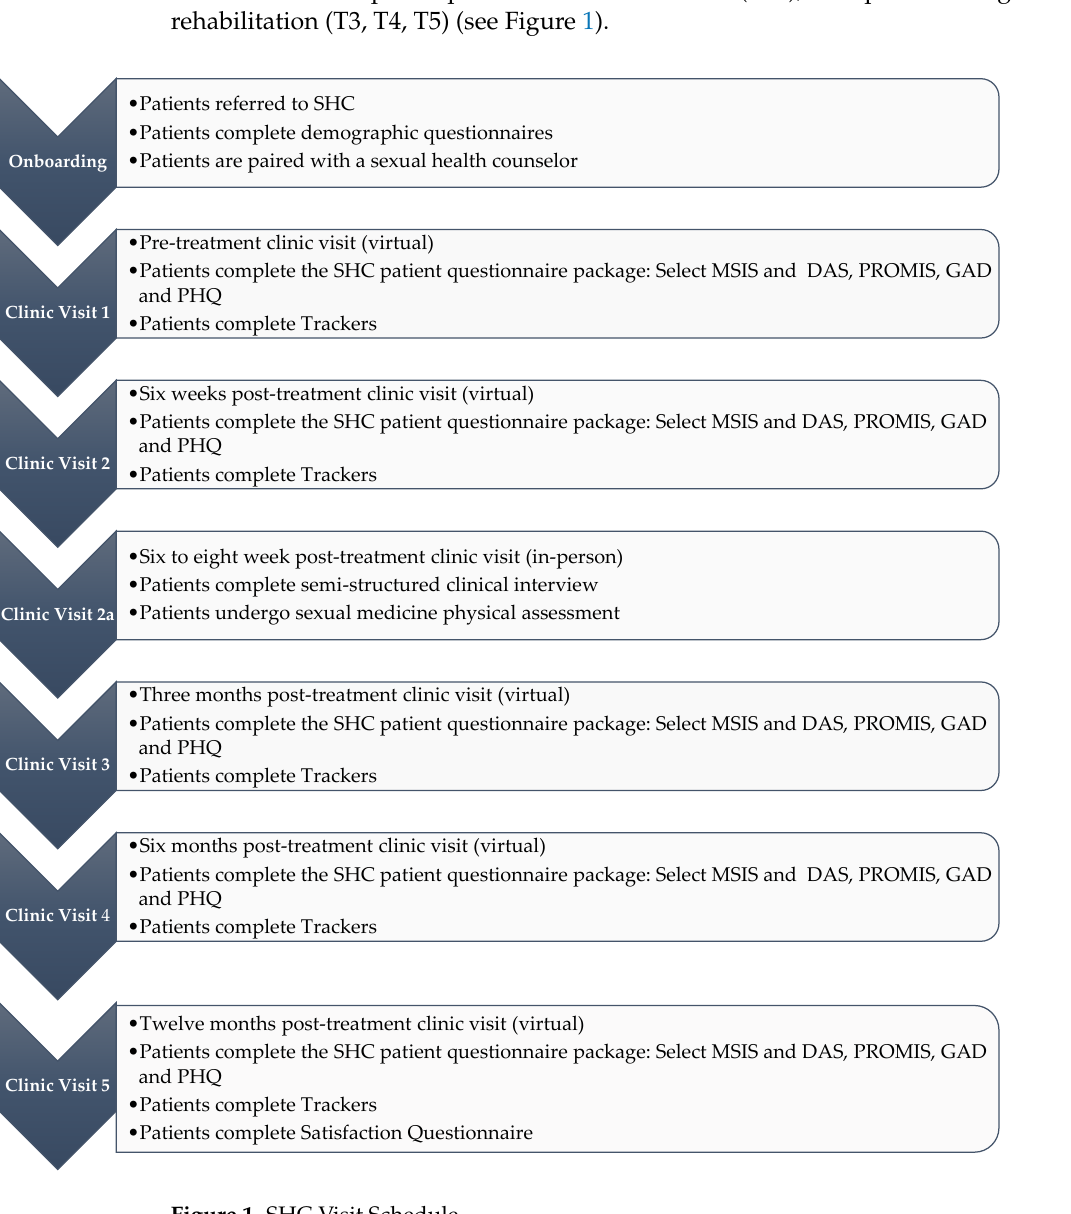
Figure 1. SHC Visit Schedule.